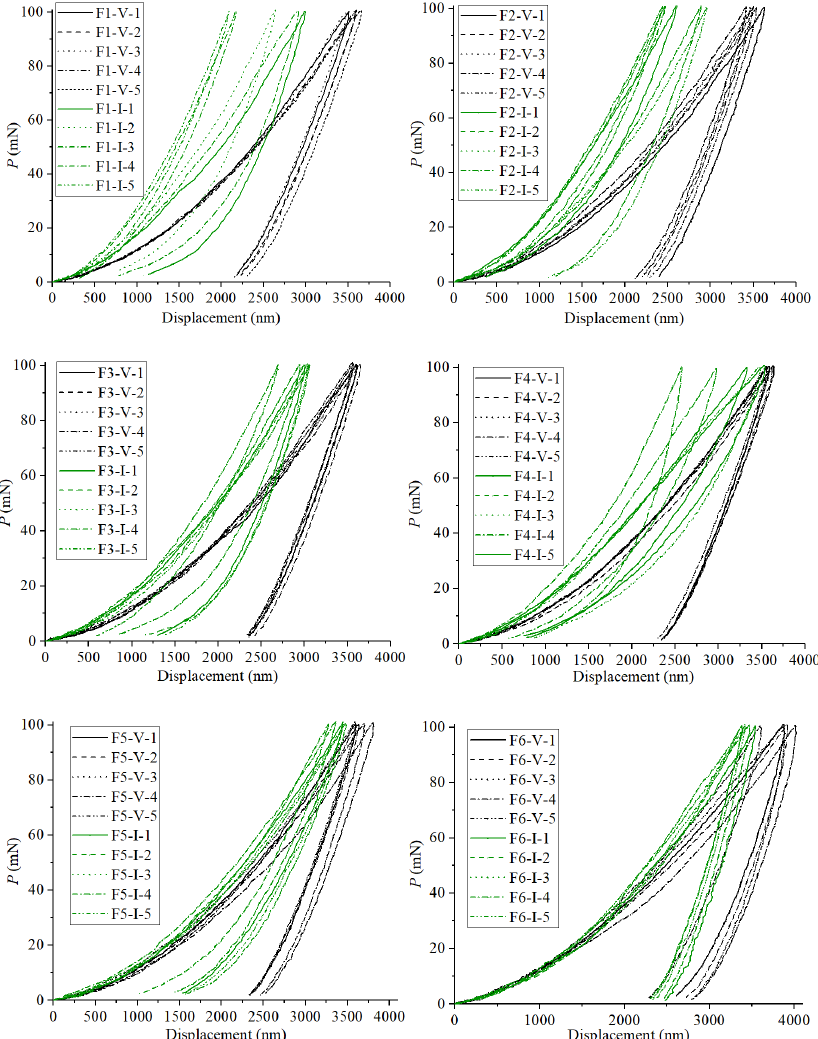
Figure 6. Load-displacement curves of samples (five measure points for each sample).